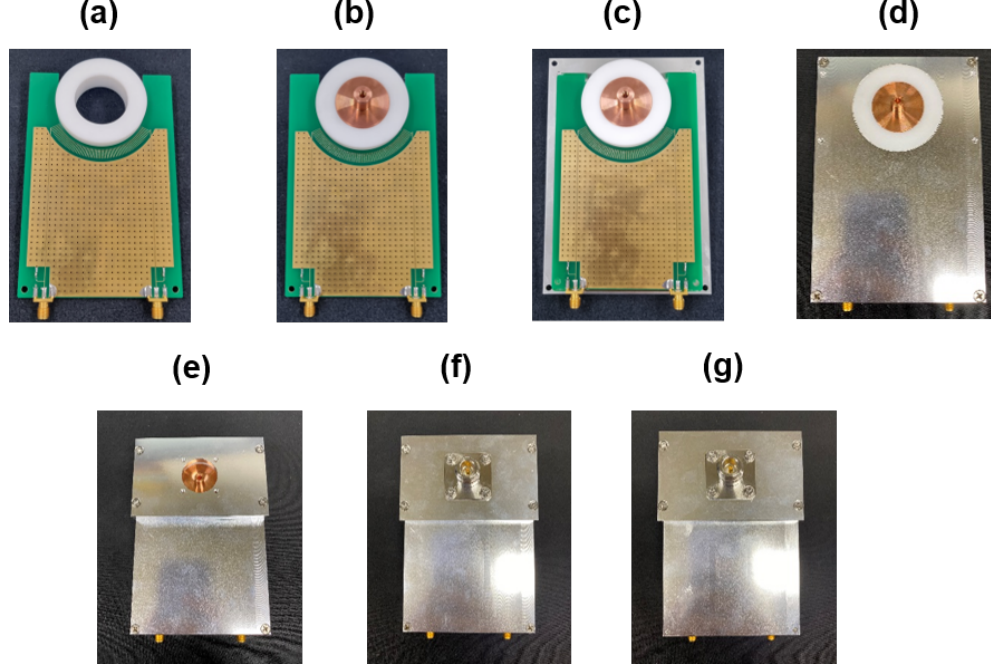
Figure 7. Photographs of the probe assembly procedure. ( a ) The U-cut printed circuit board (PCB) is inserted in the groove of a dielectric holder. ( b ) The rod is placed in the hole inside the dielectric holder. ( c ) The module is mounted on the bottom case. ( d ) The module is covered with the top case. ( e ) Mount 1 is installed. ( f ) An N-type connector is installed. ( g ) Mount 2 and an N-type connector are installed on the